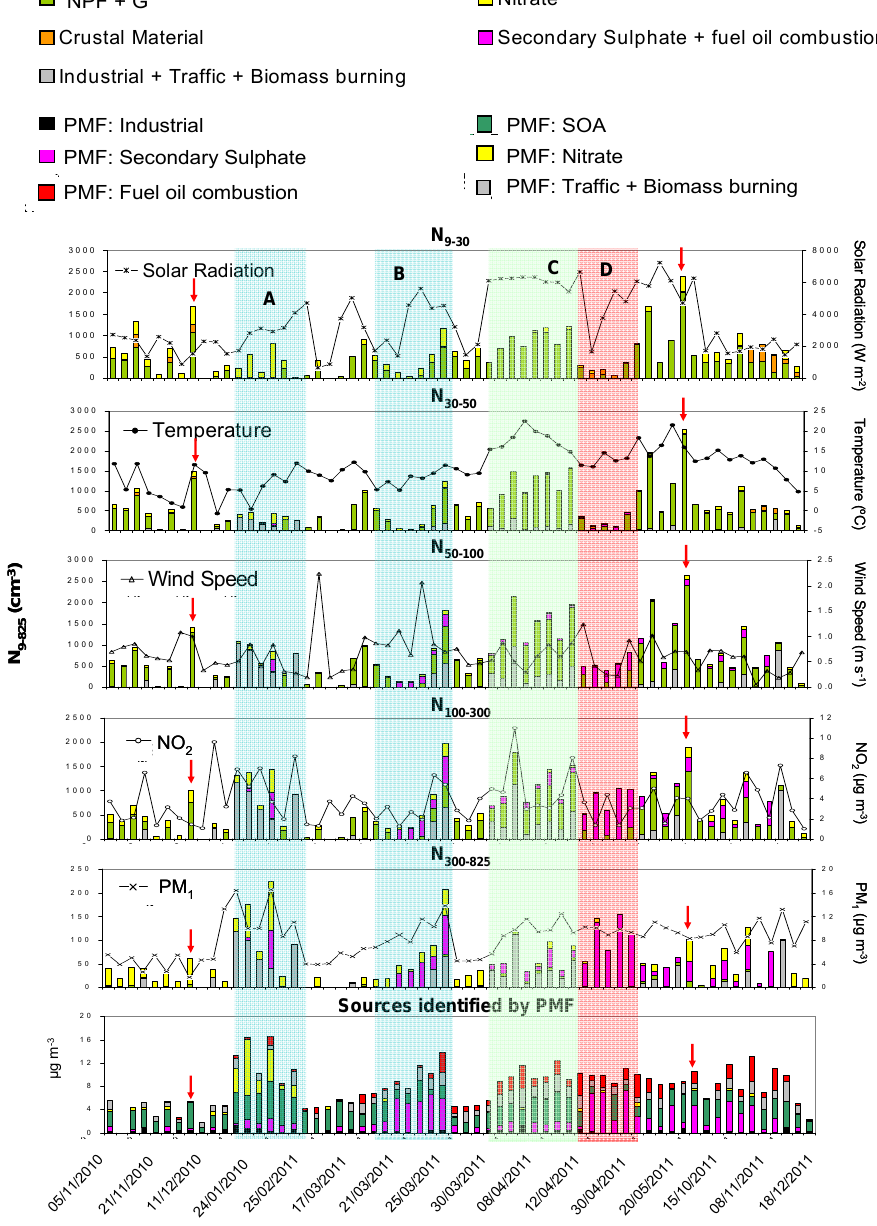
Fig. 9. Mean daily contribution of each source to the particle number concentration in various size ranges (N 9 − 825 (cm − 3 )) identified by PCA analysis. Specific aerosol episodes are highlighted: blue (A, B; WAE), green (C; NPF), red (D; summer regional recirculation). The bottom graph shows the source contribution of factors identified by PMF for the same days. Occurrence of intense NPF are highlighted by the red